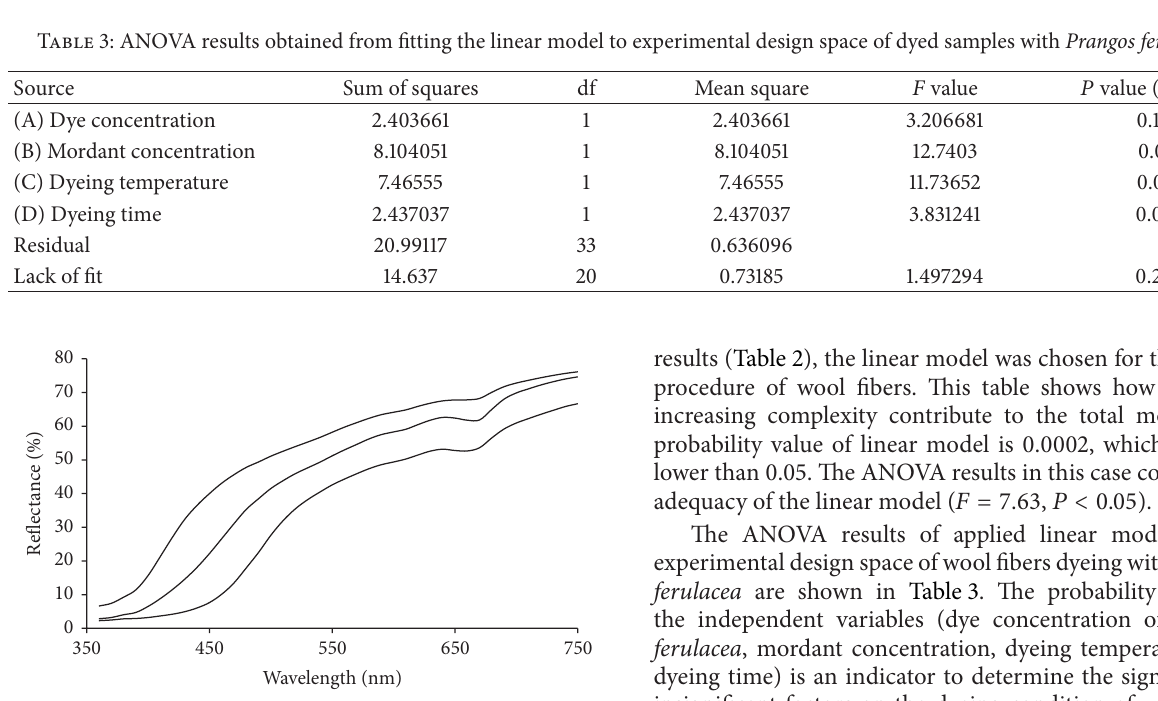
Figure 1: The three spectral reflectance of dyed wool samples with Prangos